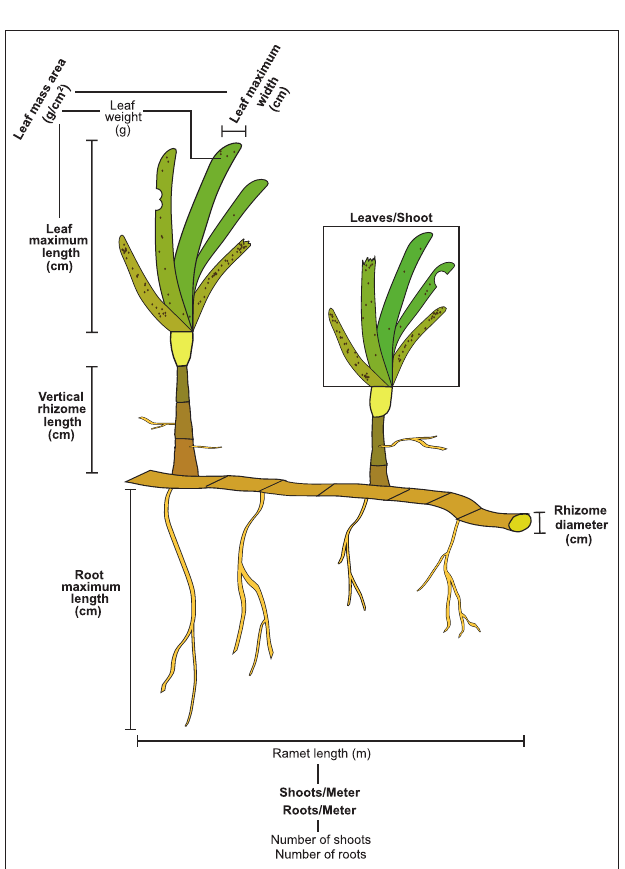
FIGURE 3 | Generic representation of a seagrass ramet and the traits measured. Traits included in the analysis are highlighted in bold. Traits that are not in bold were necessary in order to calculate the functional traits included in the